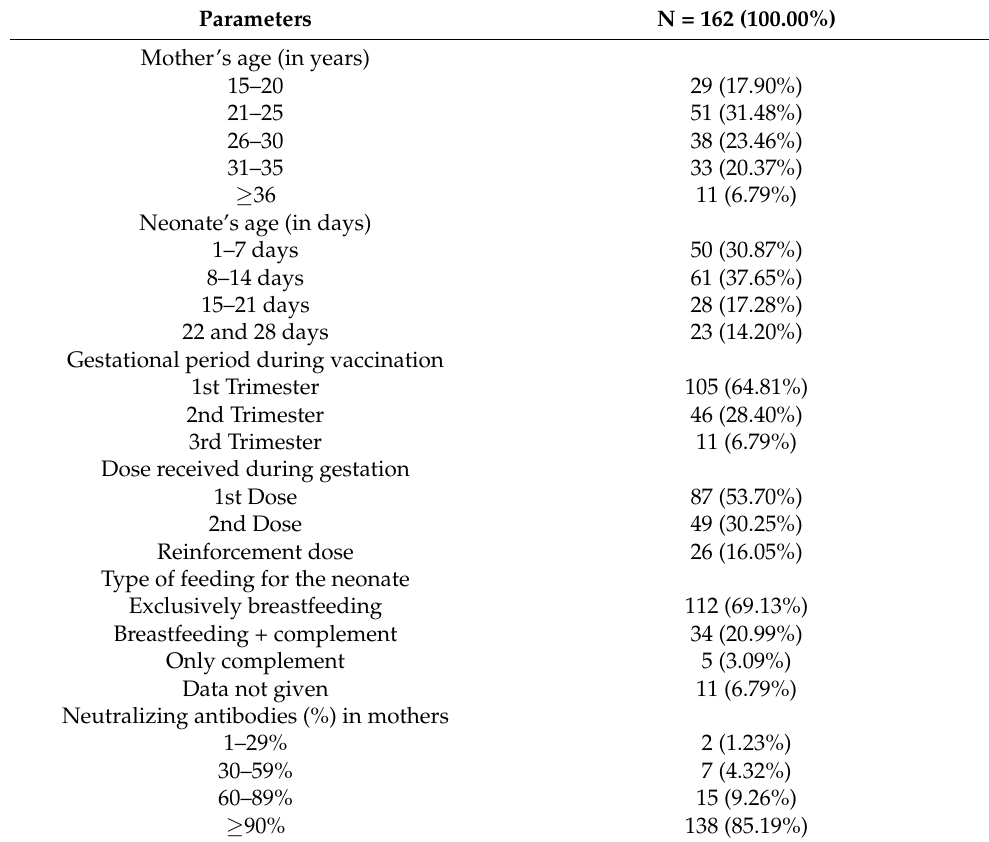
Table 1. Data from the mothers and